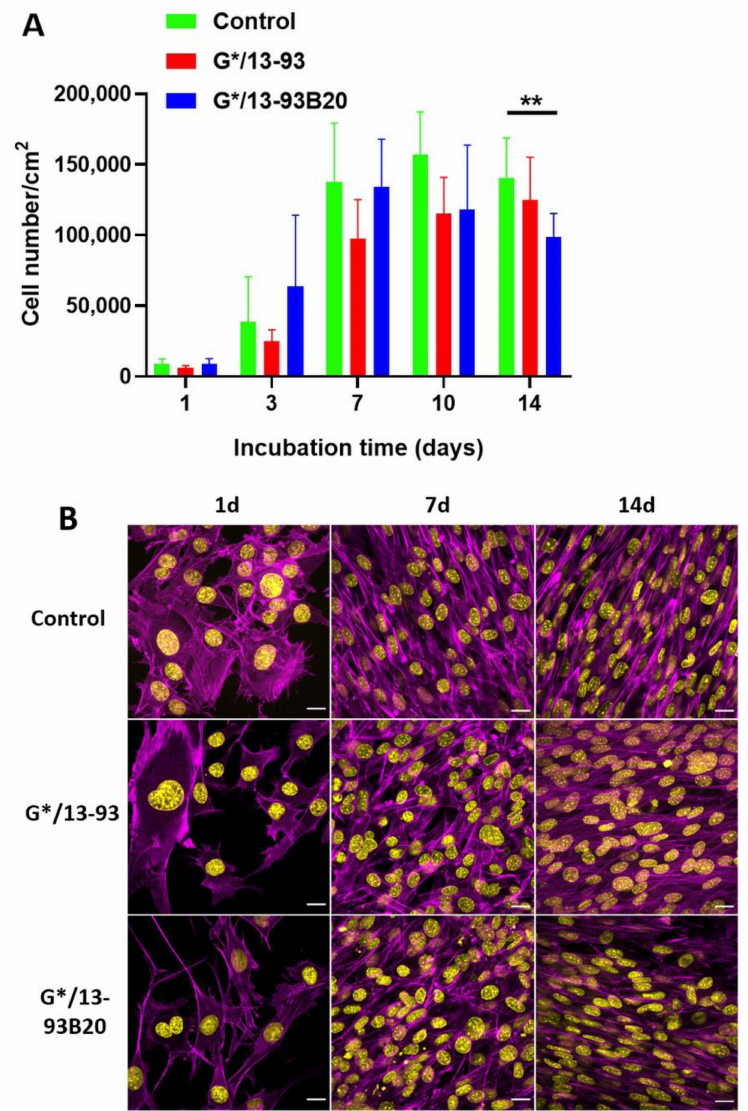
Figure 10. ( A ) Proliferation of MC3T3-E1 cells cultured in α -Minimum Essential Media ( α -MEM) complete medium on Tissue Culture Polystyrene (TCPS), G*/13-93, and G*/13-93B20 hybrids for 14 days, analyzed by a CyQUANT Cell Proliferation Assay kit. The number of cells was normalized with the area of the materials surface (** p < 0.01). ( B ) Morphology of MC3T3-E1 cells in α MEM complete medium analyzed by nuclei (4’,6-Diamidino-2-phenylindole dihydrochloride (DAPI)— yellow) and actin (phalloidin—magenta) immunostaining after 1 day, 7 days, and 14 days of culture. Scale bar 20 µ